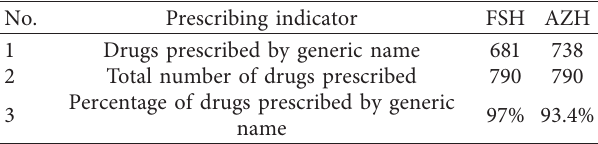
Table 5: Percentage of drugs prescribed by generic name from October 11 to November 30, 2019, at FSH and AZH, northwest